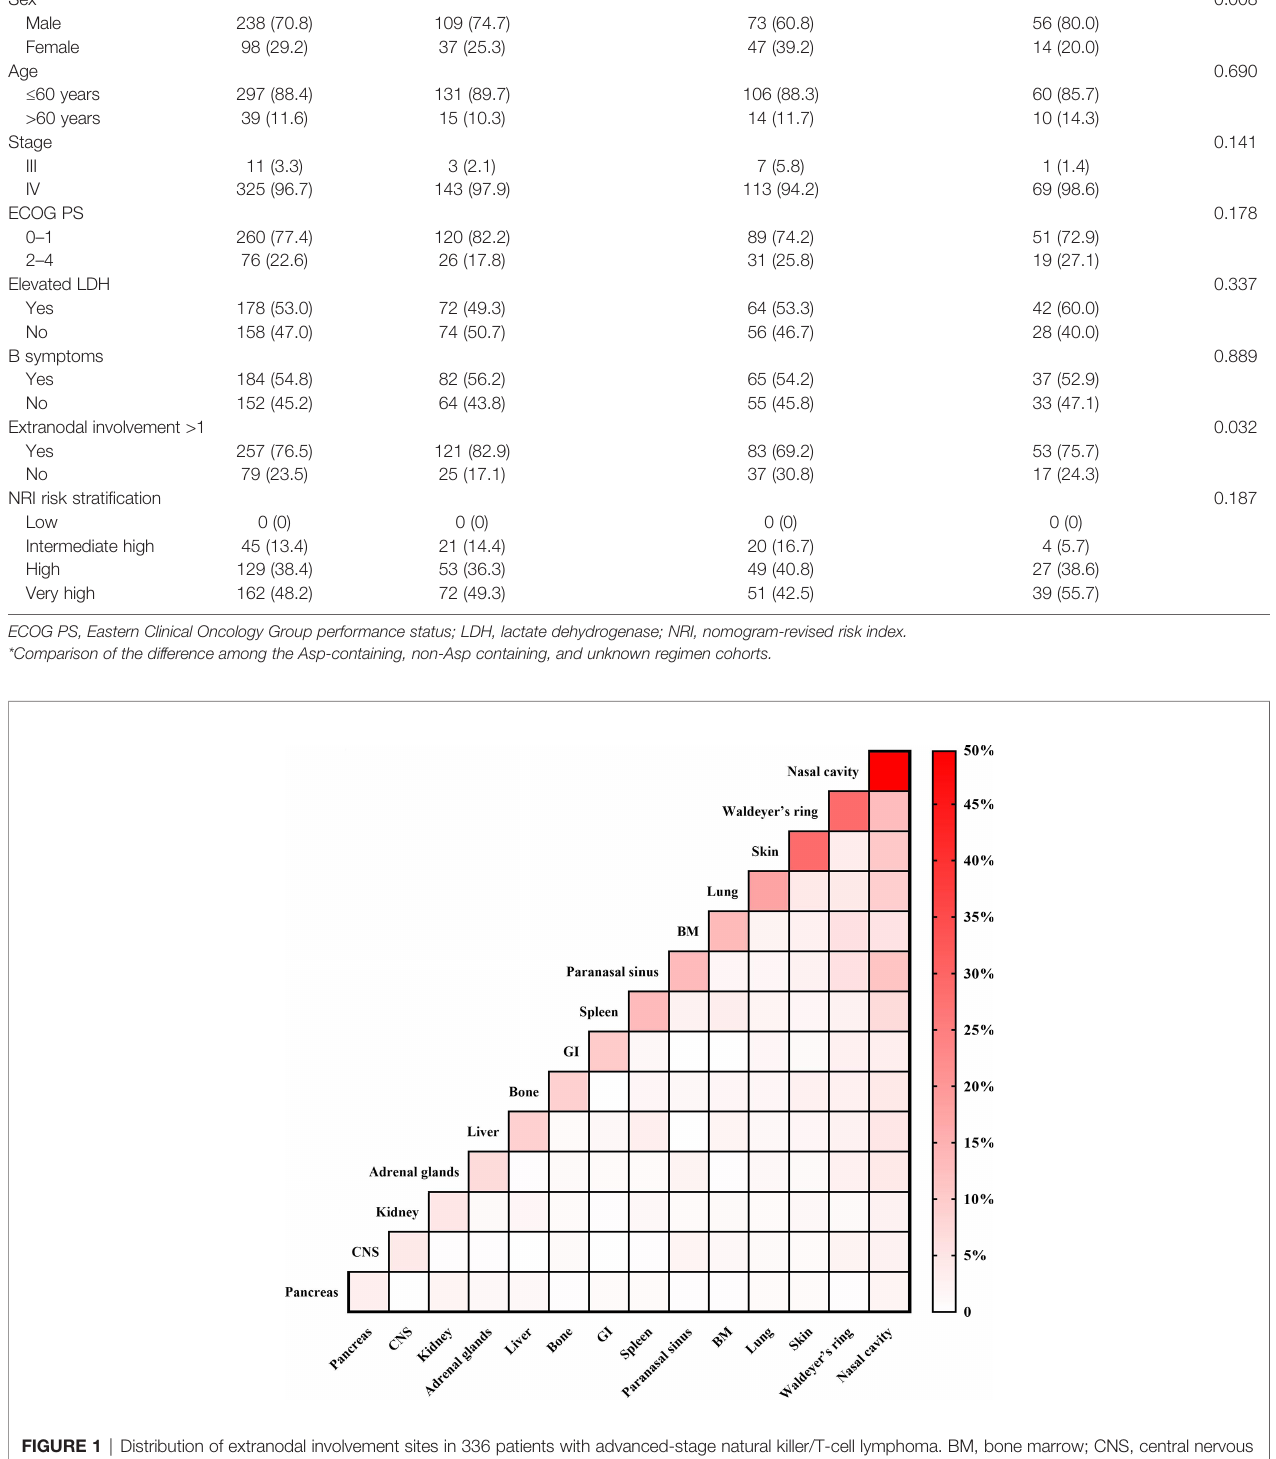
TABLE 1 | Baseline characteristics of 336 patients with advanced-stage natural killer/T-cell lymphoma. Characteristic Number (%) Total Asp-containing regimen cohort Non-Asp-containing regimen cohort Sex